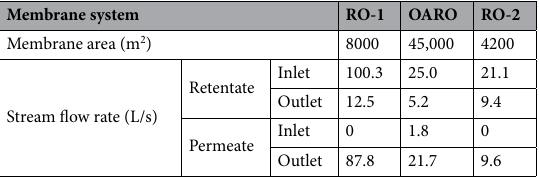
Membrane system